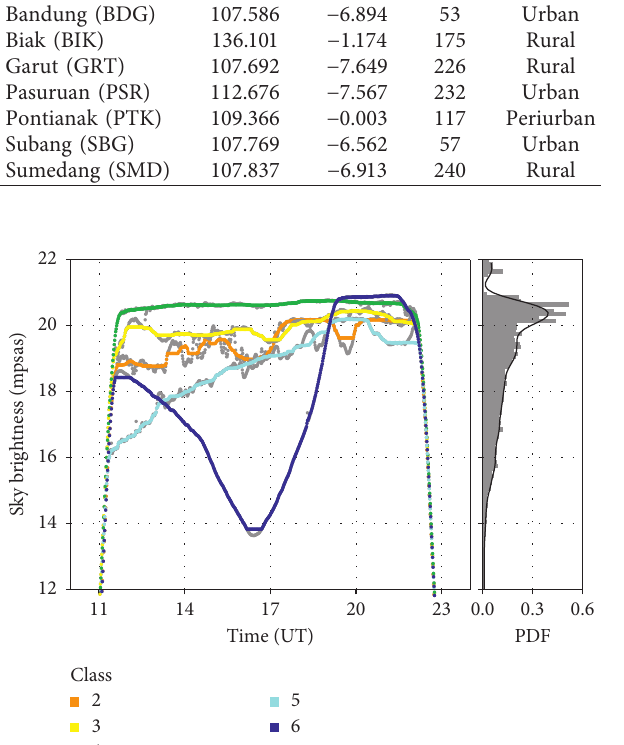
Figure 1: Illustration of nightly SQM data acquired in various conditions: overcast (class-2), cloudy (class-3), clear sky (class-4), cloudy moonlit (class-5), and clear moonlit (class-6). Raw data are displayed as gray dots while median filtered data are in color. Probability density function (PDF) constructed using whole month data is displayed on the right panel as